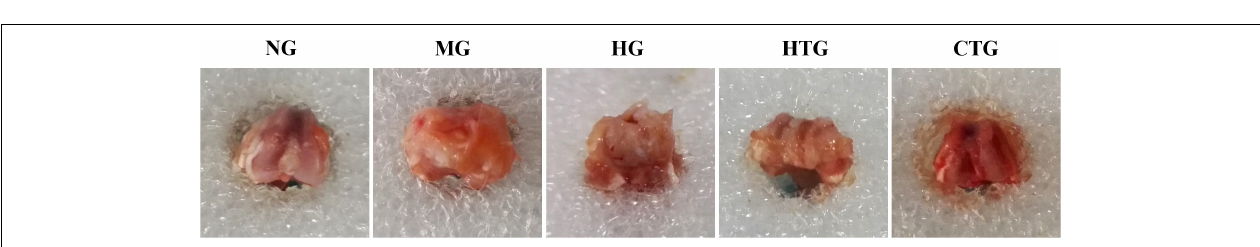
FIGURE 3 | MRI imaging of the knee joints of rat OA models after treatment. NG, LG-DMEM; MG, Model group; HG, 0.05 mg/mL HA; HTG, hAMSCs 1 × 10 6 ; CTG, HA (0.05 mg/mL) + hAMSCs (1 × 10 6 ). In the MG and HG groups, the arrows indicate the high signal of MRI showing the cartilage injury/inflammation; in the HTG and CTG groups, the arrows indicates the low signal of MRI showing the presence of hAMSCs-derived cells labeled by SPIO. 1–2 rats randomly selected from each group of six rats were used for MRI analysis.